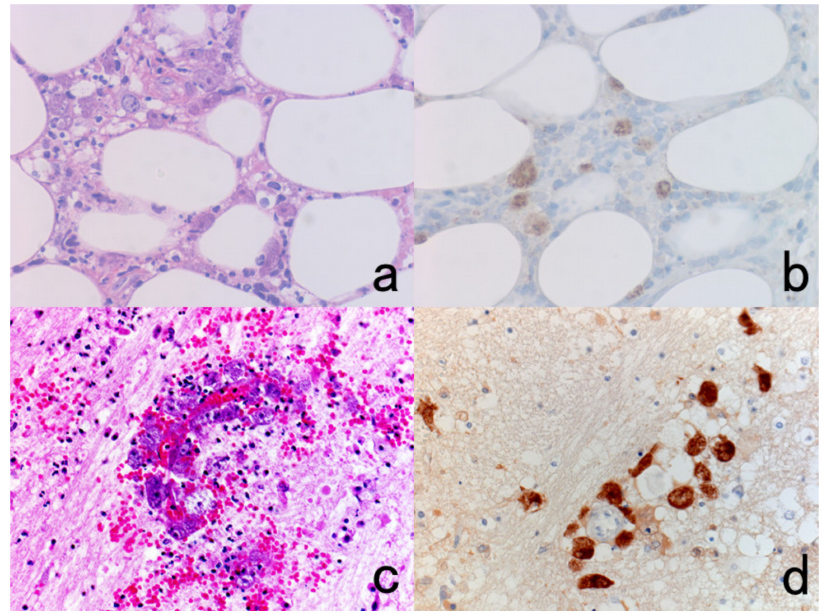
Figure 63. Immunostaining with another patient’s serum (II). Left ( a , c ): H&E and Right ( b , d ): immunostaining with 1:500 dilution of serum from another case of balamuthiasis. Balamuthia man- drillaris infection in the skin (top panels: ( a , b )) and brain (bottom panels: ( c , d )) of the same patient. Trophozoites are visible in H&E-stained cutaneous panniculitis and chronic encephalitis, and they are strongly immunoreactive with the serum from another patient who suffered Balamuthia